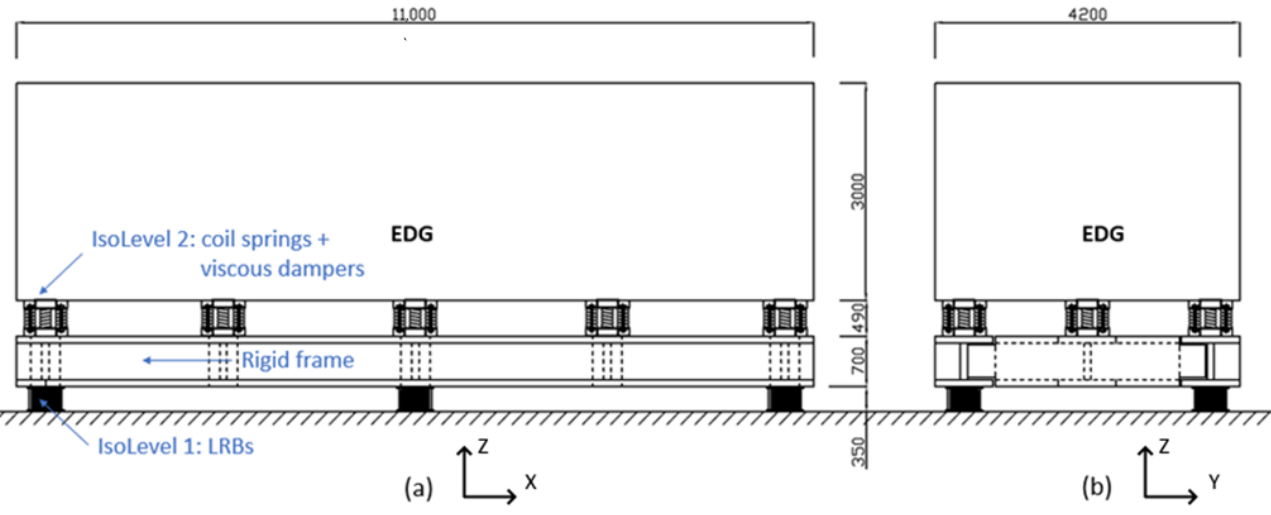
Figure 2. Proposed seismic protection configuration: ( a ) side elevation view; ( b ) front elevation view. Dimensions in millimeters.